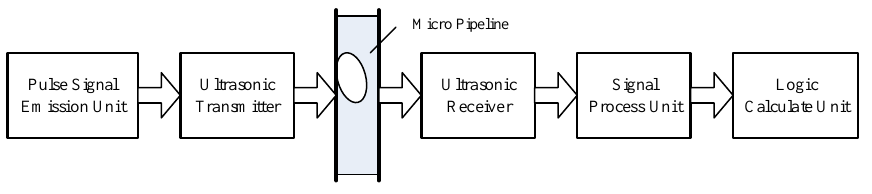
Figure 3. Flowchart of the bubble-detection